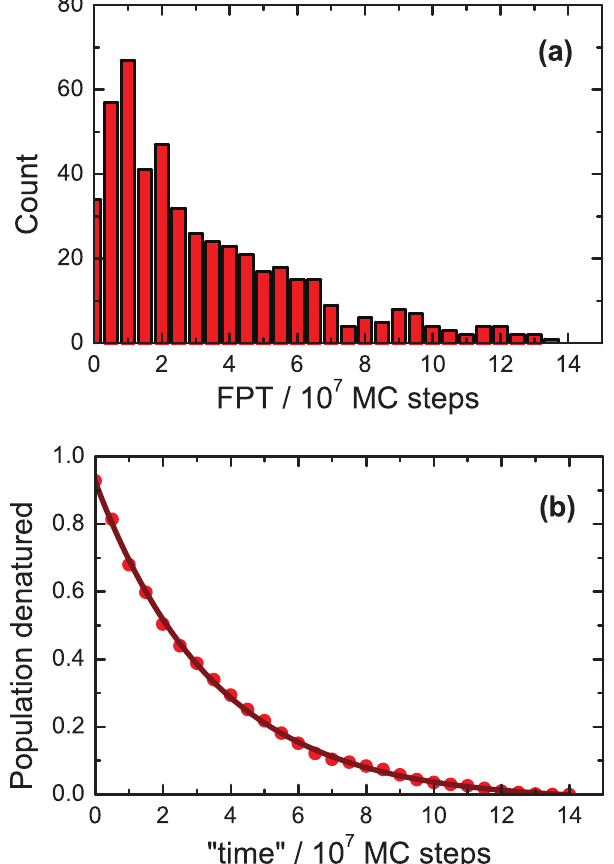
Figure 2. (a) Distribution of the first passage times of folding (FPT) for the 500 independent trajectories of a given CP. (b) "Time" evolution of the denatured state population, obtained by integration of the histogram in the upper graph. The solid line corresponds to the fitting to a single exponential decay.